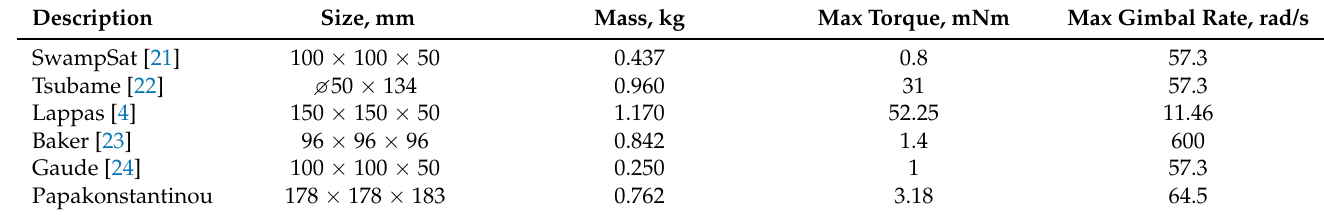
Table 10. Micro/nano-satellites with